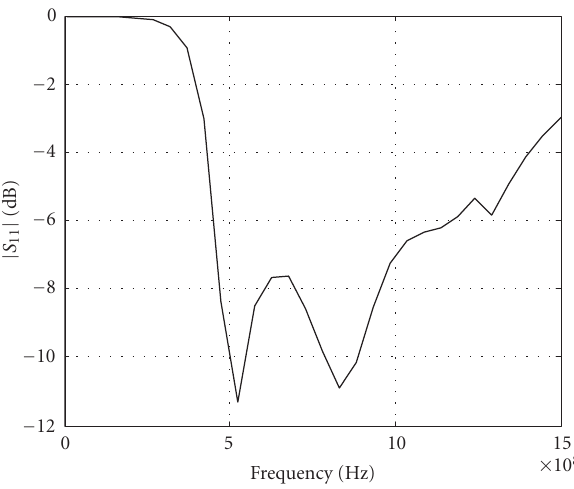
Figure 2: Simulated return loss characteristic of the HMS antenna in Figure 1.